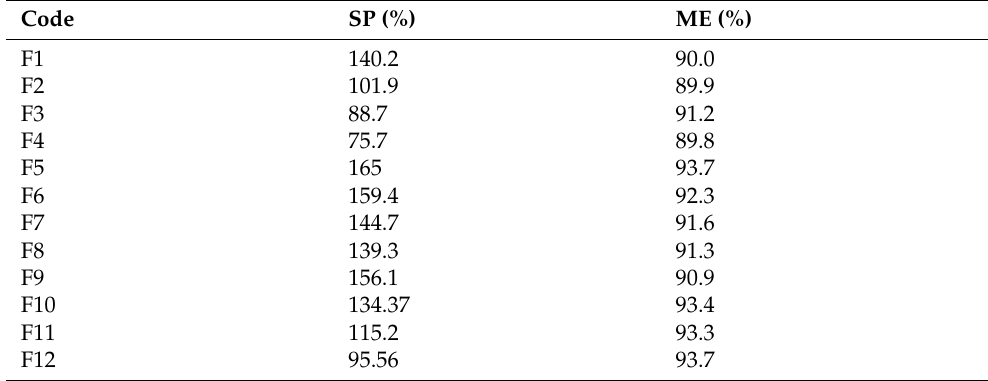
Table 2. Spreadibility and matrix erosion of gels